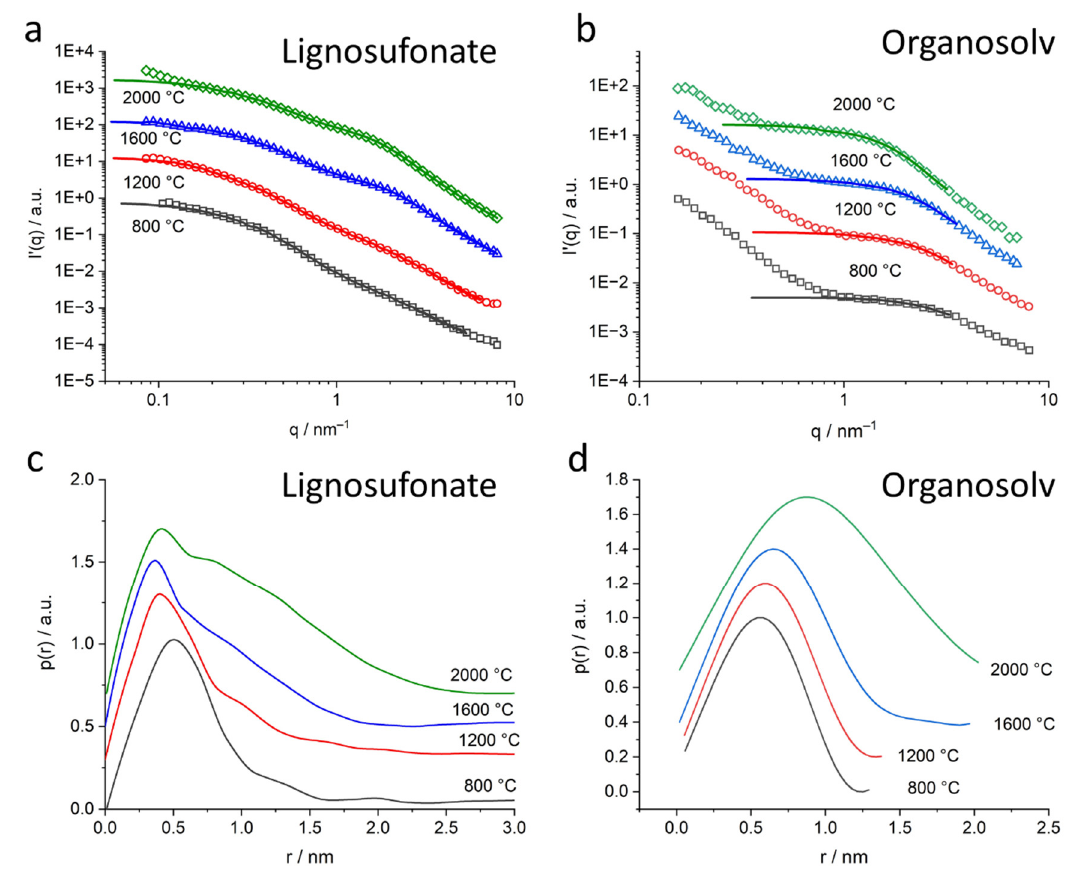
Figure 9. Evaluation of the size distribution function p ( r ) for the nanopores of lignosulfonate and organosolv samples. The scattering contribution of bigger structures has been fitted by a power law and subtracted to access the nanopores previous to the evaluation. ( a ) Lignosulfonate scattering data (symbols) together with the fit result (solid line); ( b ) organosolv scattering data (symbols) together with the fit result (solid line); ( c ) corresponding p ( r ) results of lignosulfonate; corresponding p ( r ) results of organosolv ( d ).